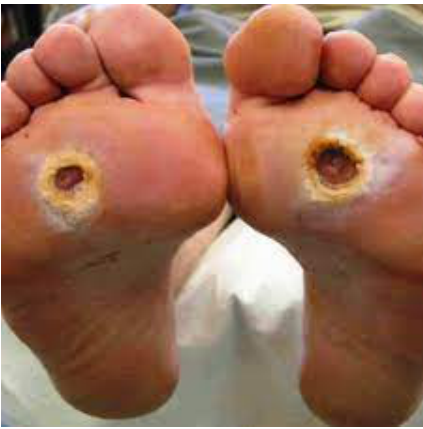
Figure 1. Diabetic foot